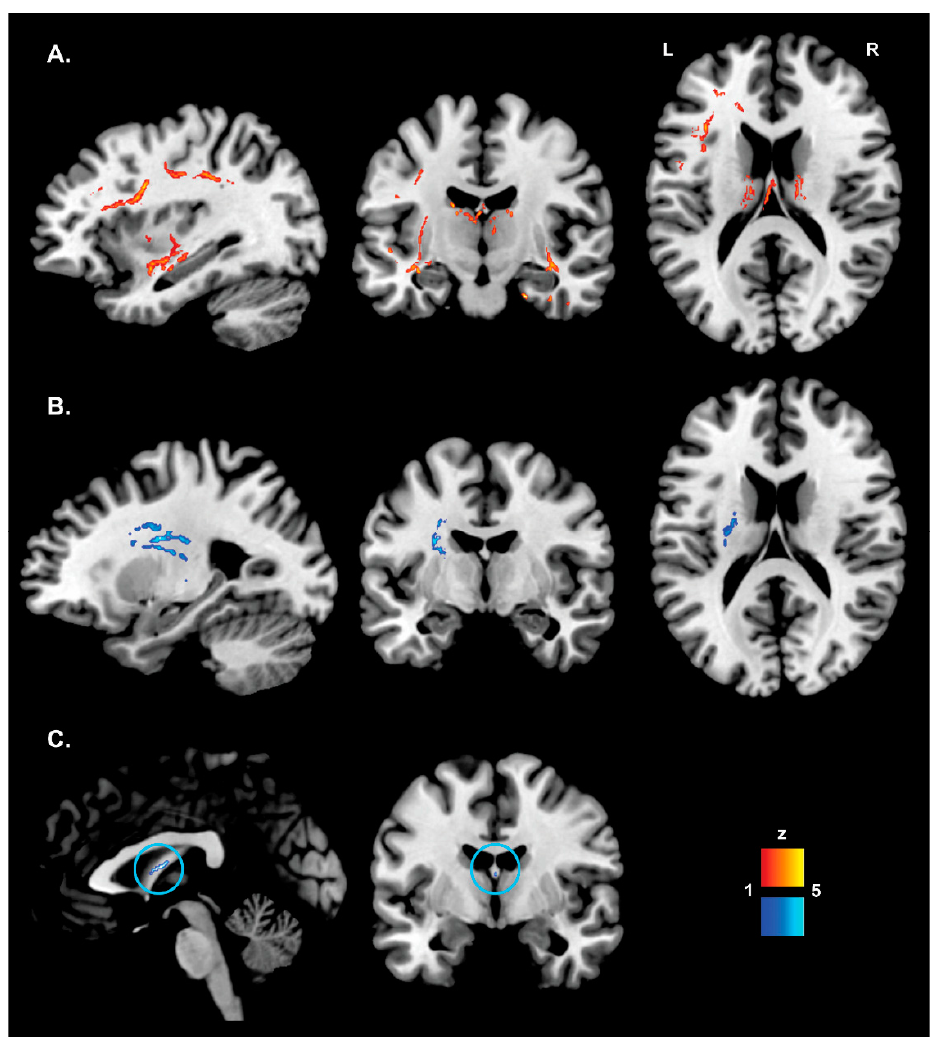
Figure 3. Clusters of altered WM microstructural integrity in the AP-PT compared with the CU group: ( A ) fractional anisotropy—AP-PT < CU; ( B ) axial diffusivity—AP-PT > CU; ( C ) radial diffusivity—AP-PT > CU (the significant small cluster in the fornix is highlighted by the blue circle).